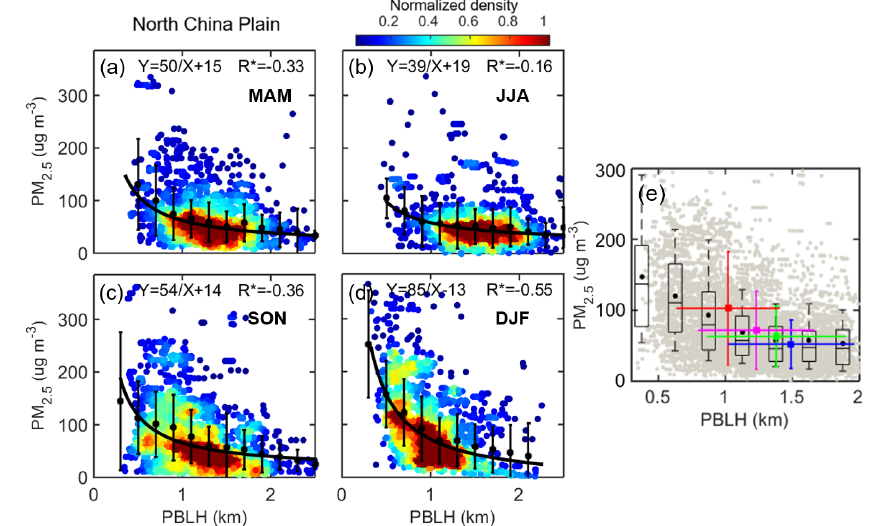
Figure 8. The relationship between CALIPSO PBLH and PM 2 . 5 over the NCP for (a) MAM, (b) JJA, (c) SON, and (d) DJF. (e) General relationship between PM 2 . 5 and PBLH aggregated over all seasons, with individual observations for each day plotted as gray dots. The box-and-whisker plots showing 10th, 25th, 50th, 75th, and 90th percentile values of PM 2 . 5 for each bin. The green, blue, pink, and red dots present the mean values for MAM, JJA, SON, and DJF, respectively.